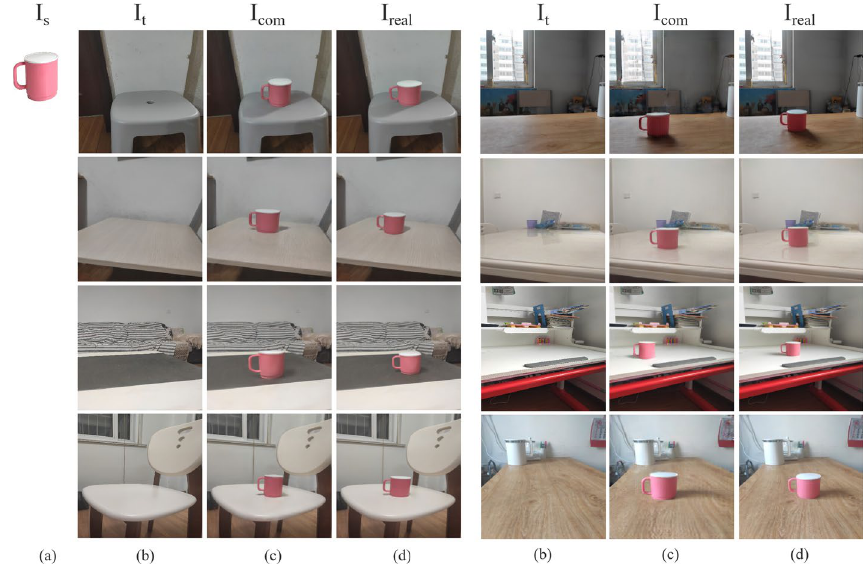
Fig. 2 Image compositing results of one source sample and eight target samples on SHU dataset: a source object, b target image, c compositing image, and d ground truth: a source object, b target image, c compositing image, and d ground